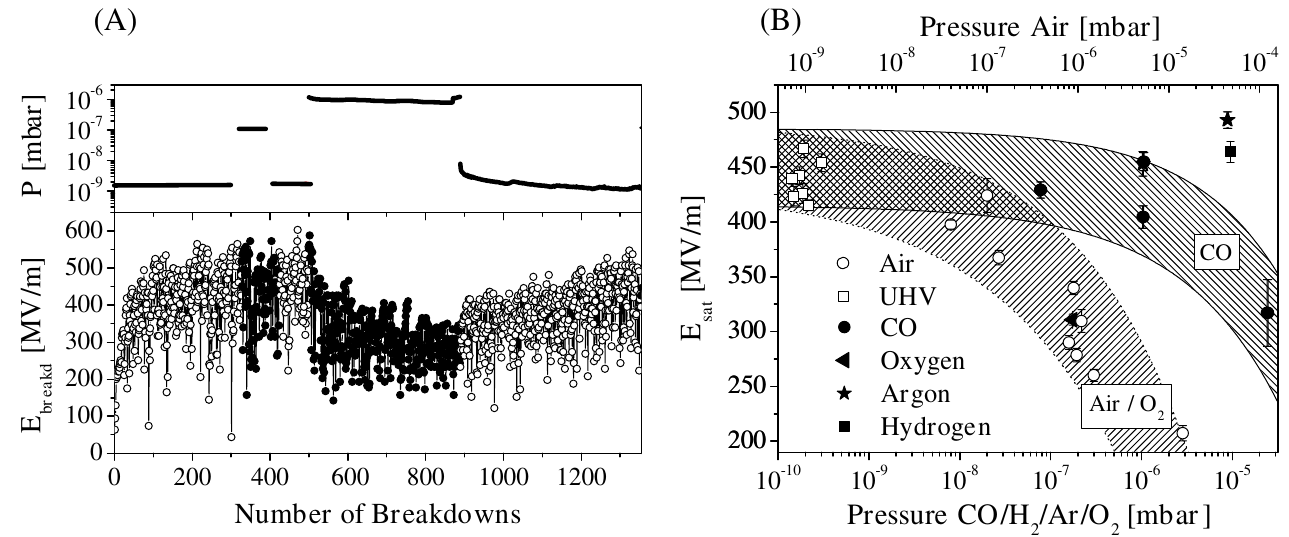
FIG. 1. Breakdown fields for molybdenum in UHVand the effect of gas pressures of air, O shows the conditioning curve of molybdenum, where the vertical axis gives the maximum achieved applied electric field in MV = m before breakdown. The upper graph shows the average pressure of air for each measurement point. The horizontal axis gives the accumulated number of breakdowns with constant cathode/anode position. (B) Variation of the saturated breakdown field (vertical axis) with gas pressures (horizontal axes). The upper horizontal axis shows the absolute pressure of air, and is shifted by a factor of 5 to higher values relative to the lower axis. The shaded areas surrounding the data points symbolize the variation as a function of air and CO pressure, respectively. The vertical bars denote the resulting standard